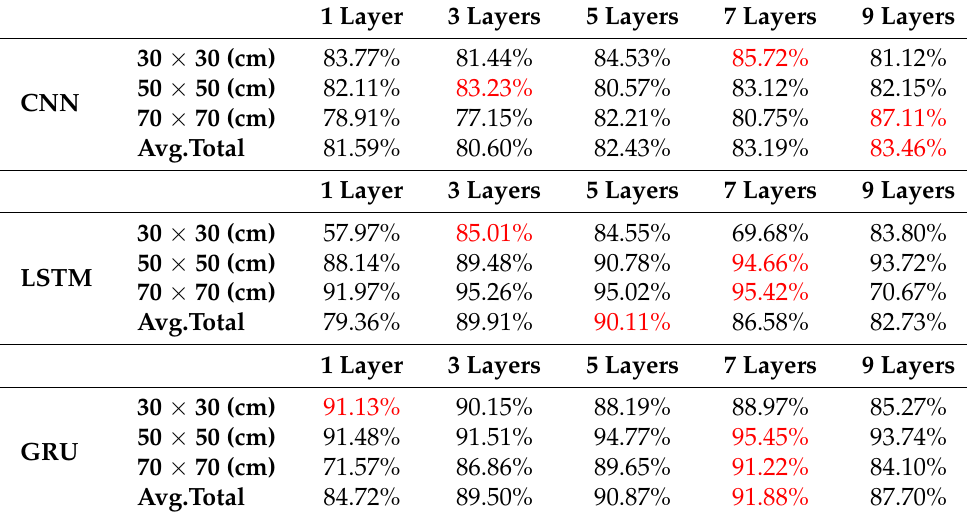
Table 3. 50 cm distance between the steel plate and sensor. Red is the best